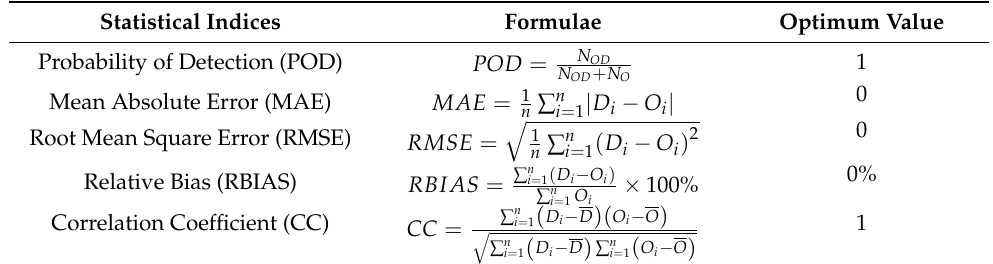
Table 2. List of statistical evaluation indices utilized to assess the IMERG-E, IMERG-L, and IMERG-F.